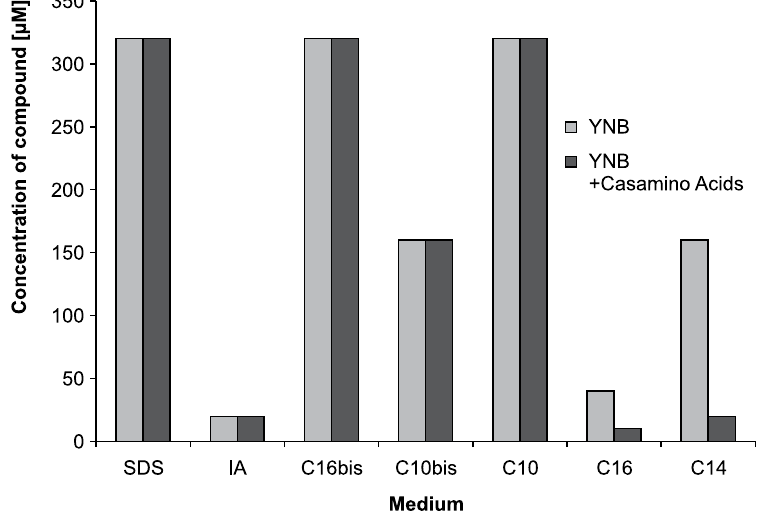
Fig. 2. Growth of T.cutaneum on YNB and YNB+CA at the presence of amphifilic com-